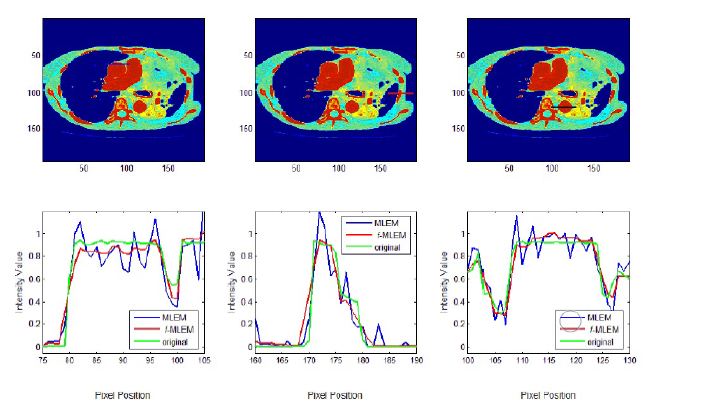
Figure 9. 1D Line profile of two reconstruction algorithms across different